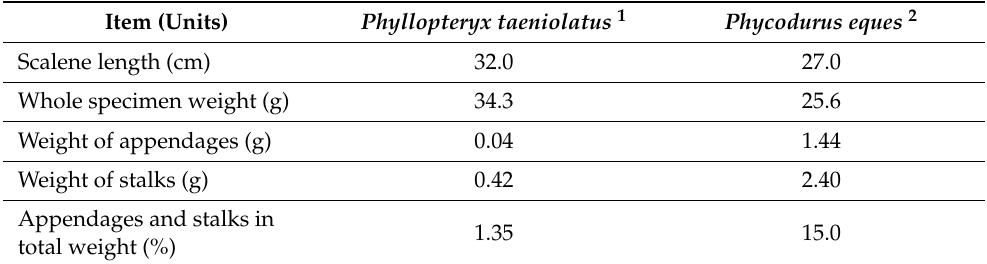
Table 5. Contributions of the appendages and their supporting spines to the weight of two species of seadragons, based on two preserved specimens.